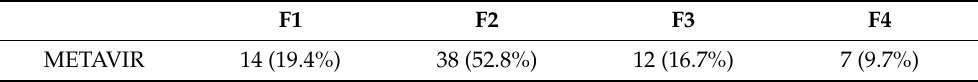
Table 2. Distribution of liver fibrosis stages in the study population according to pathological examination.